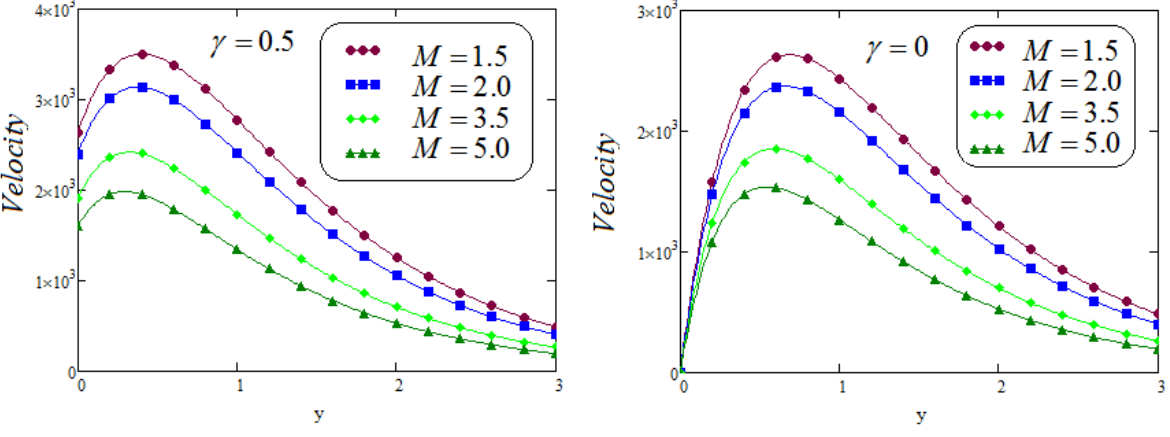
Figure 10. Velocity field under slip conditions as well as the velocity field under no-slip conditions for different M values when f ( t ) = sint , t = 1.5, Gr = 3.5, λ 1 = 0.6, λ 2 = 0.2, Pr = 0.71.